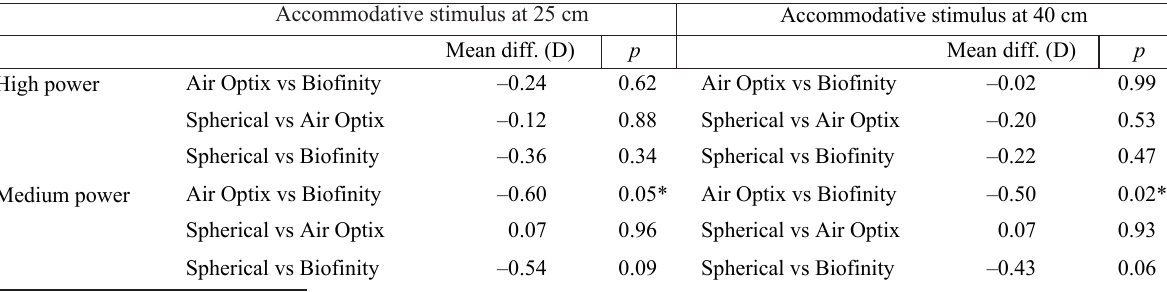
For analysis we used the two-way ANOVA test along with Tukeyʼs multiple comparisons test.